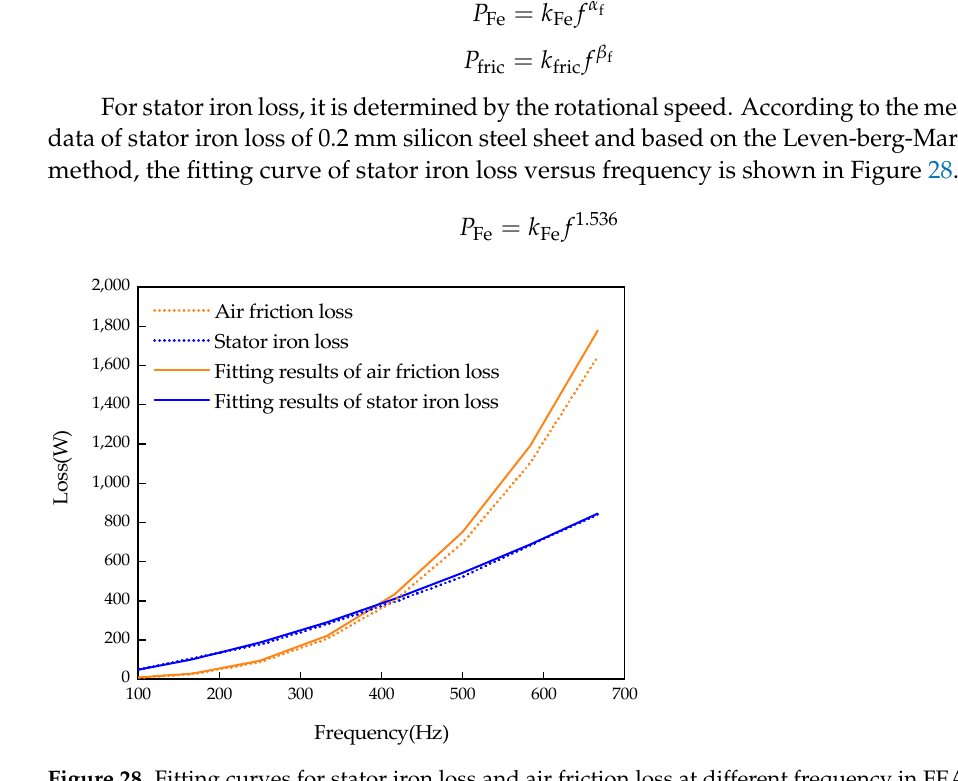
Figure 28. Fitting curves for stator iron loss and air friction loss at different frequency in FEA.